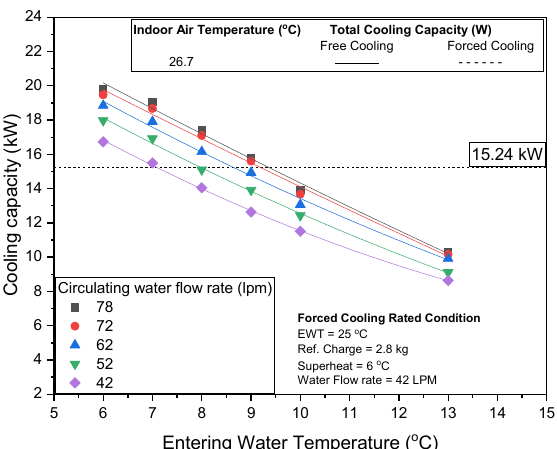
Figure 13. MCT variation according to secondary fluid flow rate variation.